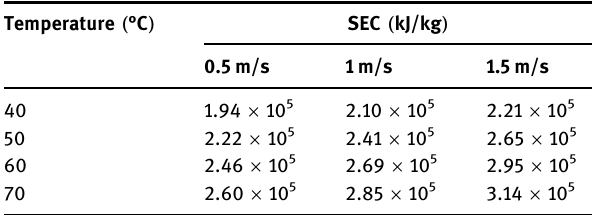
Table 1: Speci fi c energy consumption for the thin - layer convective drying of potatoes Temperature ( °C